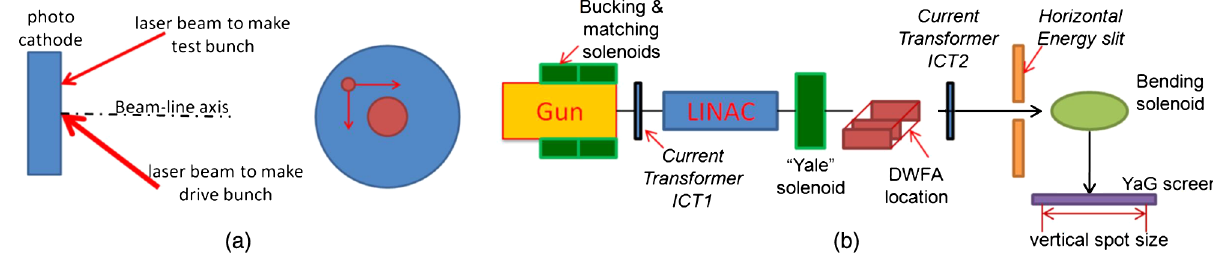
FIG. 9. (a) Time-delayed test bunch is produced off axis on the same photocathode where the drive bunch was produced. (b) Beam- line elements essential to guide and focus both bunches; steering coils and beam position monitors (YAG screens) are not